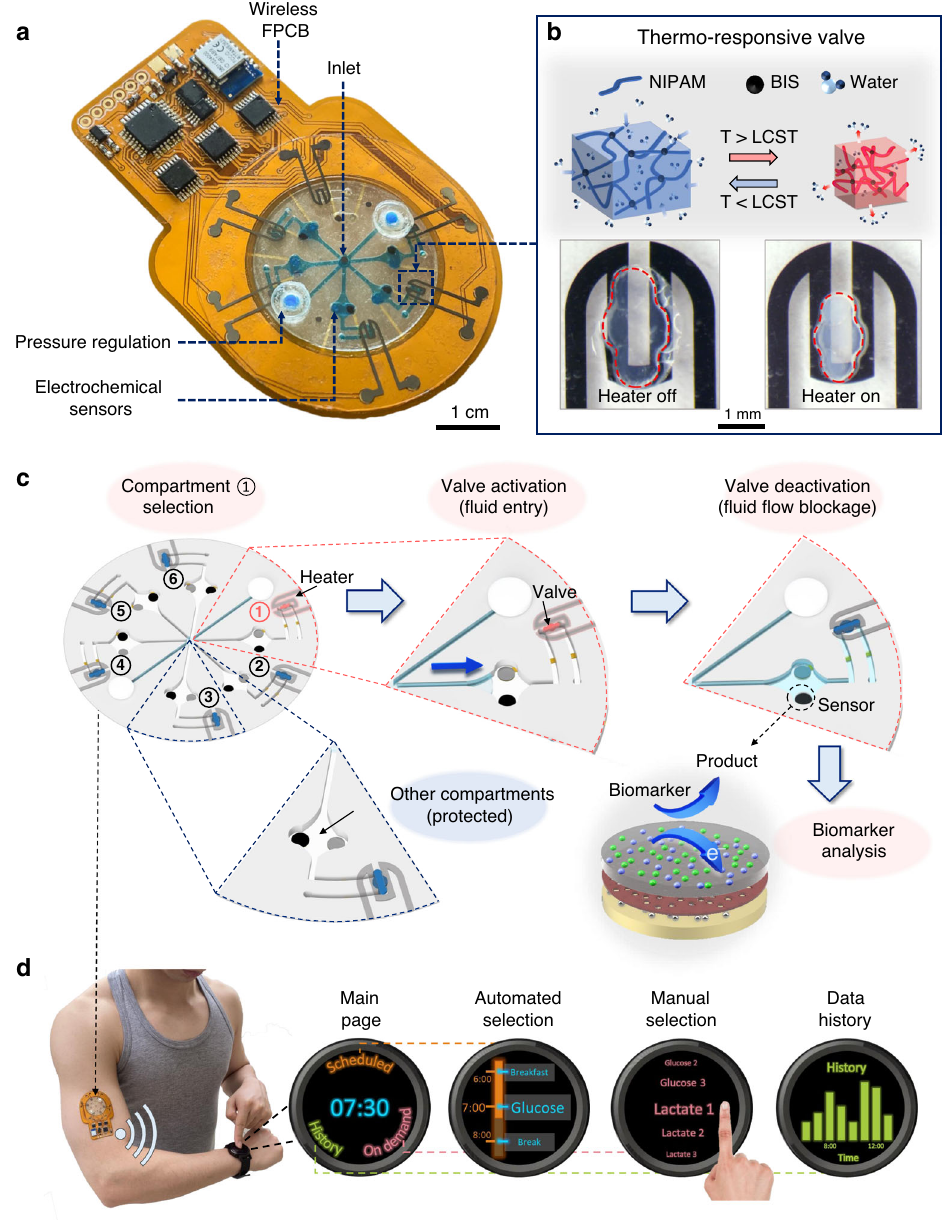
Fig. 1 A fully integrated wearable valving system (concept and operational principle). a Illustration of a representative wearable bioanalytical